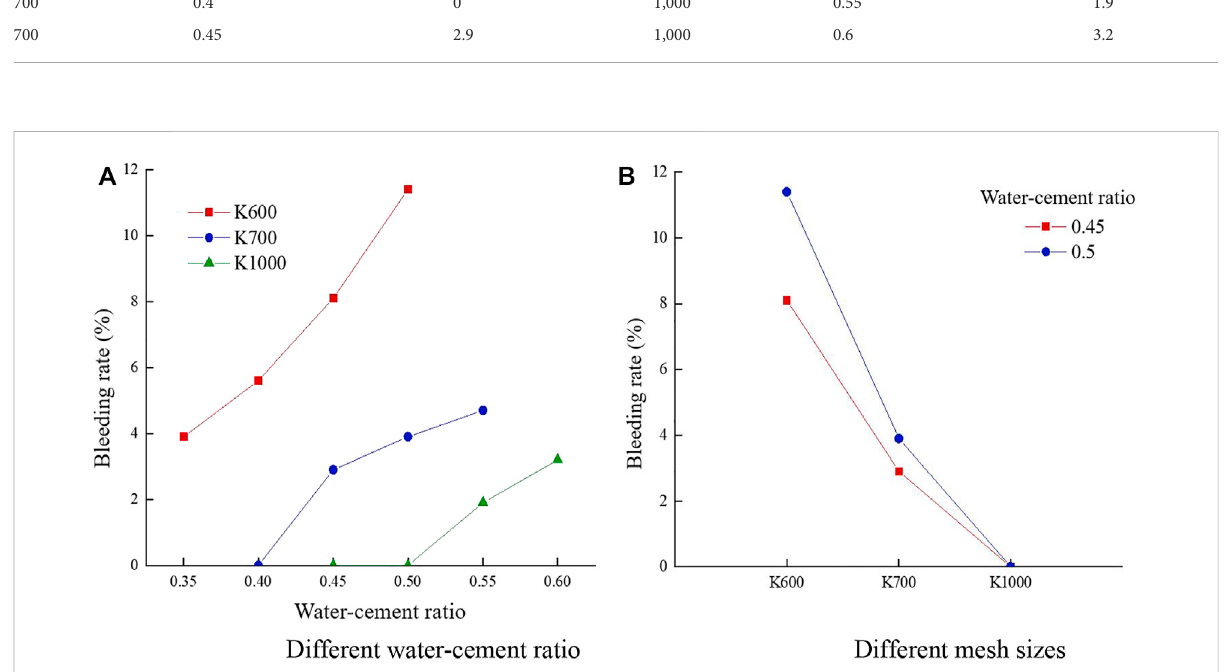
FIGURE 10 Variation law of bleeding rate of super fi ne